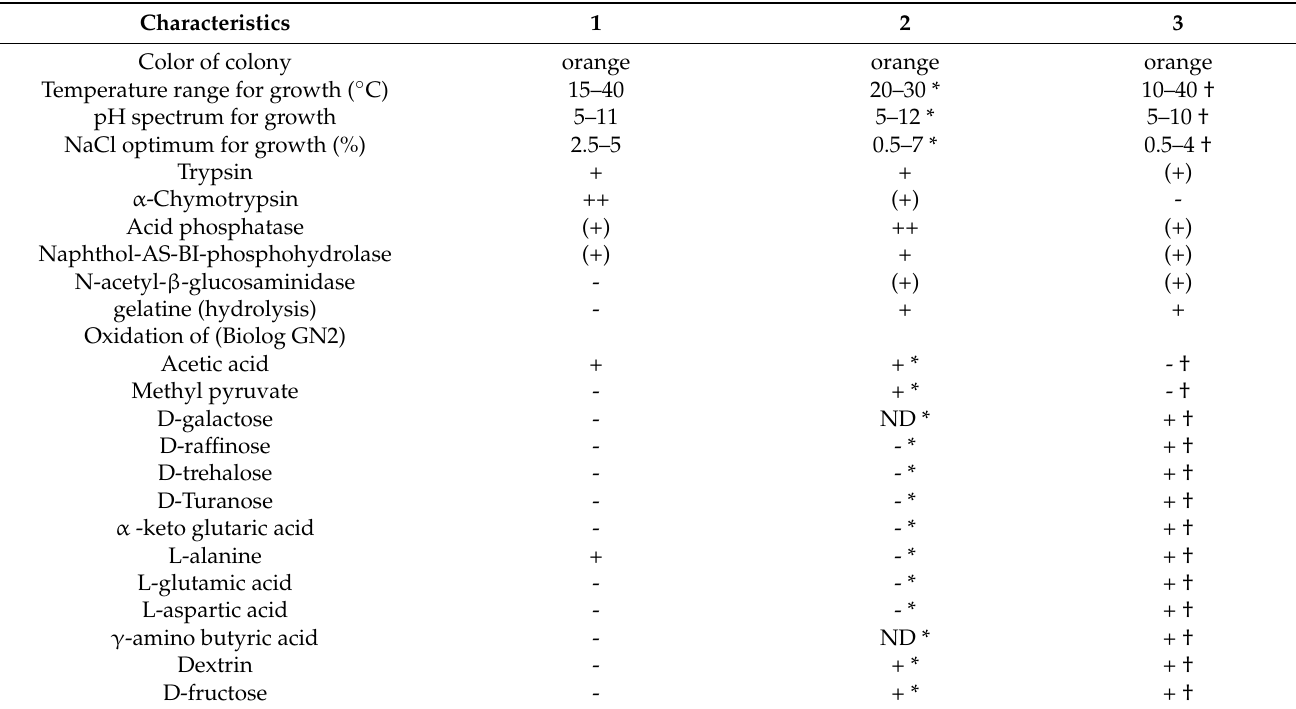
Table 3. Comparison of phenotypic characteristics that distinguish strain WHA3 T from the most closely related type strains. Strains: 1, Pacificimonas pallium WHA3 T ; 2, Pacificimonas flava